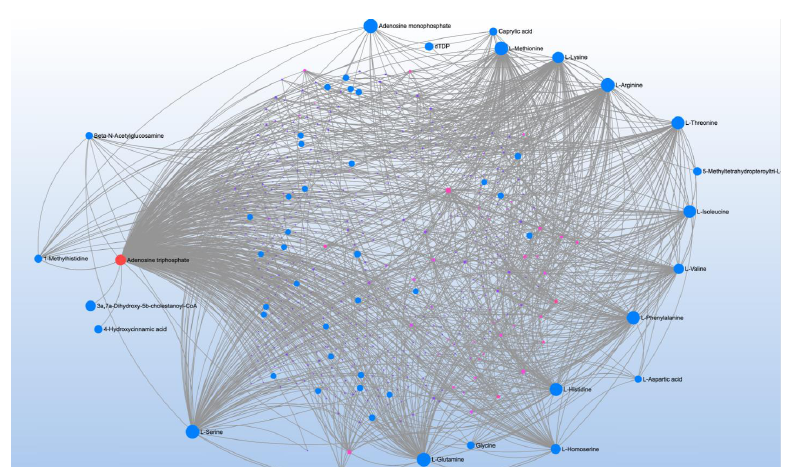
Figure 8. Metabolite-metabolite interaction network for significant metabolites that correlate methylation potential (S-adenosylmethionine to S-adenosylhomocysteine ratio). Size of the node indicates importance in the network. The interaction analysis highlights the importance of energy metabolism including glucogenic and ketogenic amino acids.